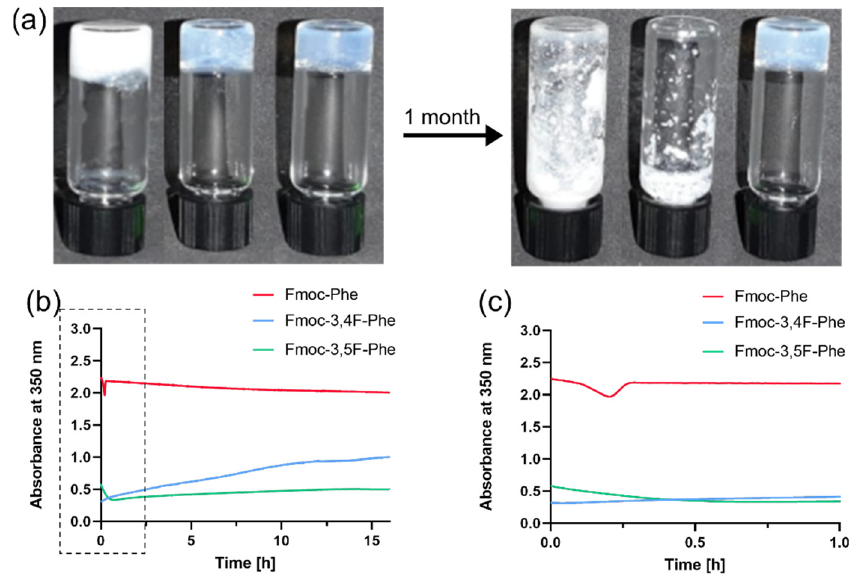
Figure 2. Kinetic characterization of the assemblies. ( a ) Hydrogels formed from Fmoc-Phe derivatives one-hour post gelation (left side) and one-month post gelation (right side). Vials from left to right: Fmoc-Phe, Fmoc-3,4F-Phe, and Fmoc-3,5F-Phe. ( b ) OD kinetics at 350 nm for the first 16 hours of hydrogel formation. ( c ) Higher scale enlargement of the OD kinetics for the first hour (dashed area).